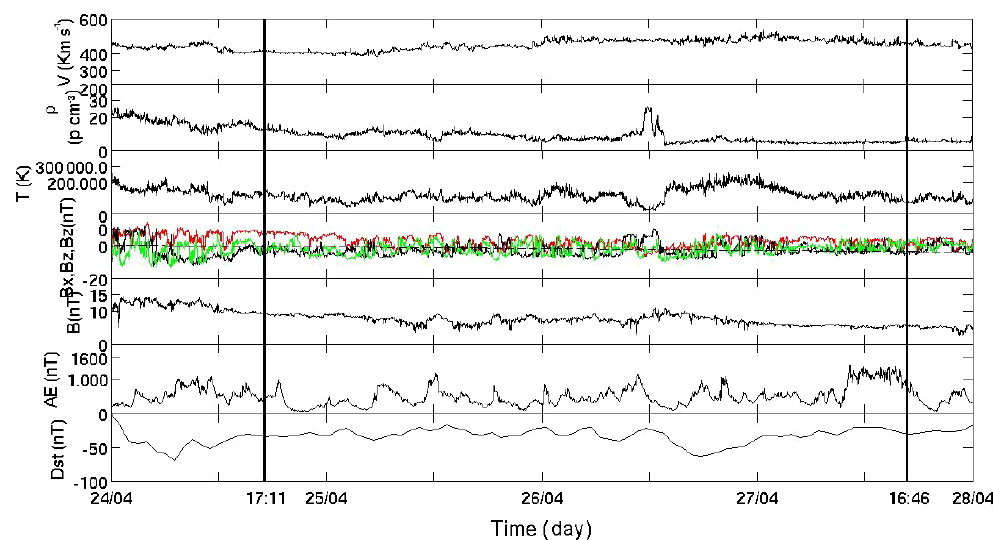
Figure 1. Solar wind parameters and geomagnetic indices during the HILDCAA event occurring from 17:11UT on 24 April to 16:46UT on 27 April 1998. From top to bottom, the panels show the solar wind speed; density; temperature; IMF components B x (red), B y (black), and B z (green); the IMF magnitude; the AE index; and the Dst index.